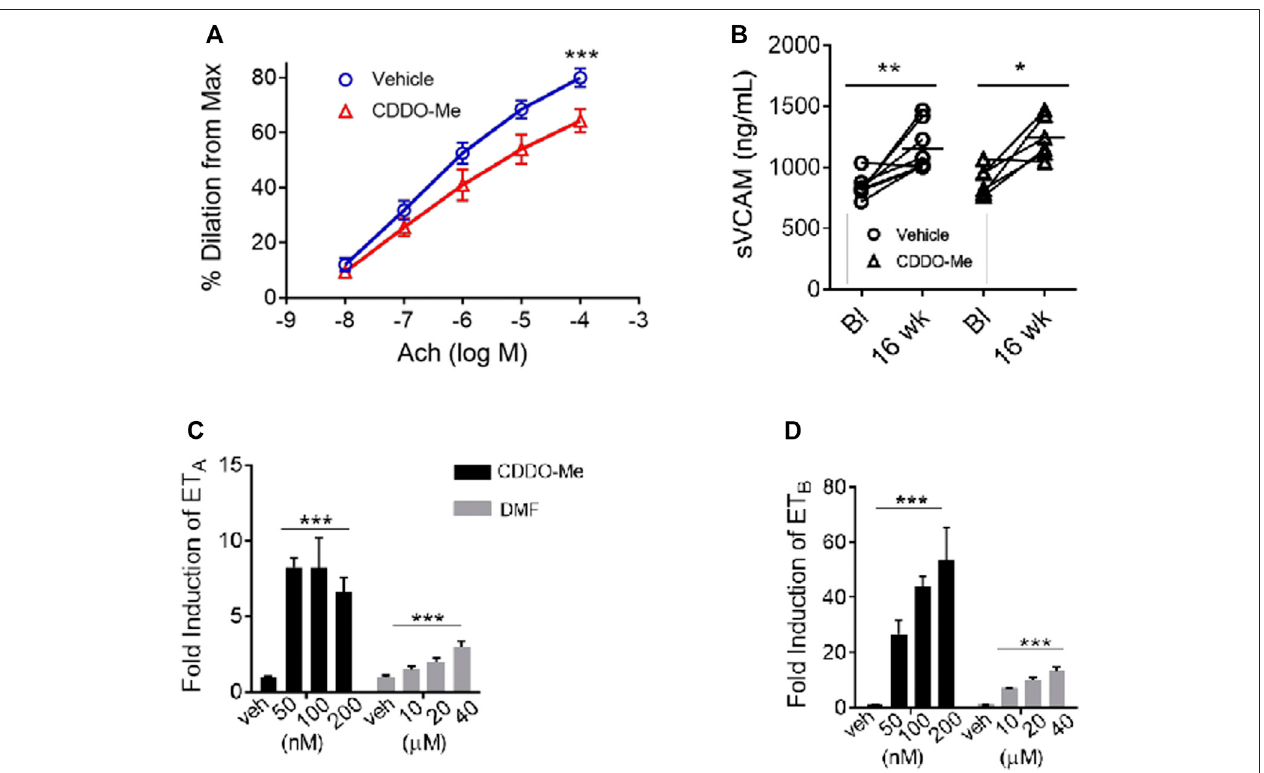
FIGURE 2 | CDDO-Me worsens the vasodilatory response of pulmonary artery vessels from SS mice. CDDO-Me and DMF induced the genetic expression of the endothelin receptor A (ET A ) and B (ET B ) in rat smooth muscle cells. SS mice were randomly chosen at 4 – 6 weeks of age to be treated for 16 weeks with CDDO-Me (20 μ mol/kg) or vehicle (DMSO) byoral gavage asdescribed in Figure 1 . (A) Fornitric oxide (NO) responseanalysis, weused wiremyography which quanti fi ed changes in vessel vasodilationand vasoconstriction. Lungs ofSSmice treated for 16 weeks withCDDO-Me or vehicle werecontractedwithacontinuousdose response of Endothelin-1 (100 pM-10 nM). After reaching plateau (max constriction), endothelial function was examined with a continuous dose response curve of acetylcholine (10 nM – 100 mM) to produce relaxation ( n = 5 for each group, ppp p < 0.001, 2-way ANOVA). (B) We used ELISA assays for soluble vCAM toassess the effect CDDO-Me had on in fl ammation. Plasma samples were isolated from whole blood collected at baseline and after 16 weeks of treatment (vehicle n = 8, CDDO-Me n = 8; * p < 0.05, pp p < 0.01, ns, not signi fi cant, Student ’ s t-test). Real-time PCR was used to analyze and compare the drug-induced temporal expression of the endothelin receptor A (ET A ) and B (ET B ). (C,D) We cultured rat smooth muscle cells and treated them with CDDO-Me (50,100, and 200 nM), DMF (10, 20, and 40 μ M) or vehicle for 6 – 24 h. RNA was isolated for cDNA synthesis and analyzed using real-time PCR ( n = 6 biological replicates; p p < 0.05, pp p < 0.01, ppp p < 0.001, NS, not signi fi